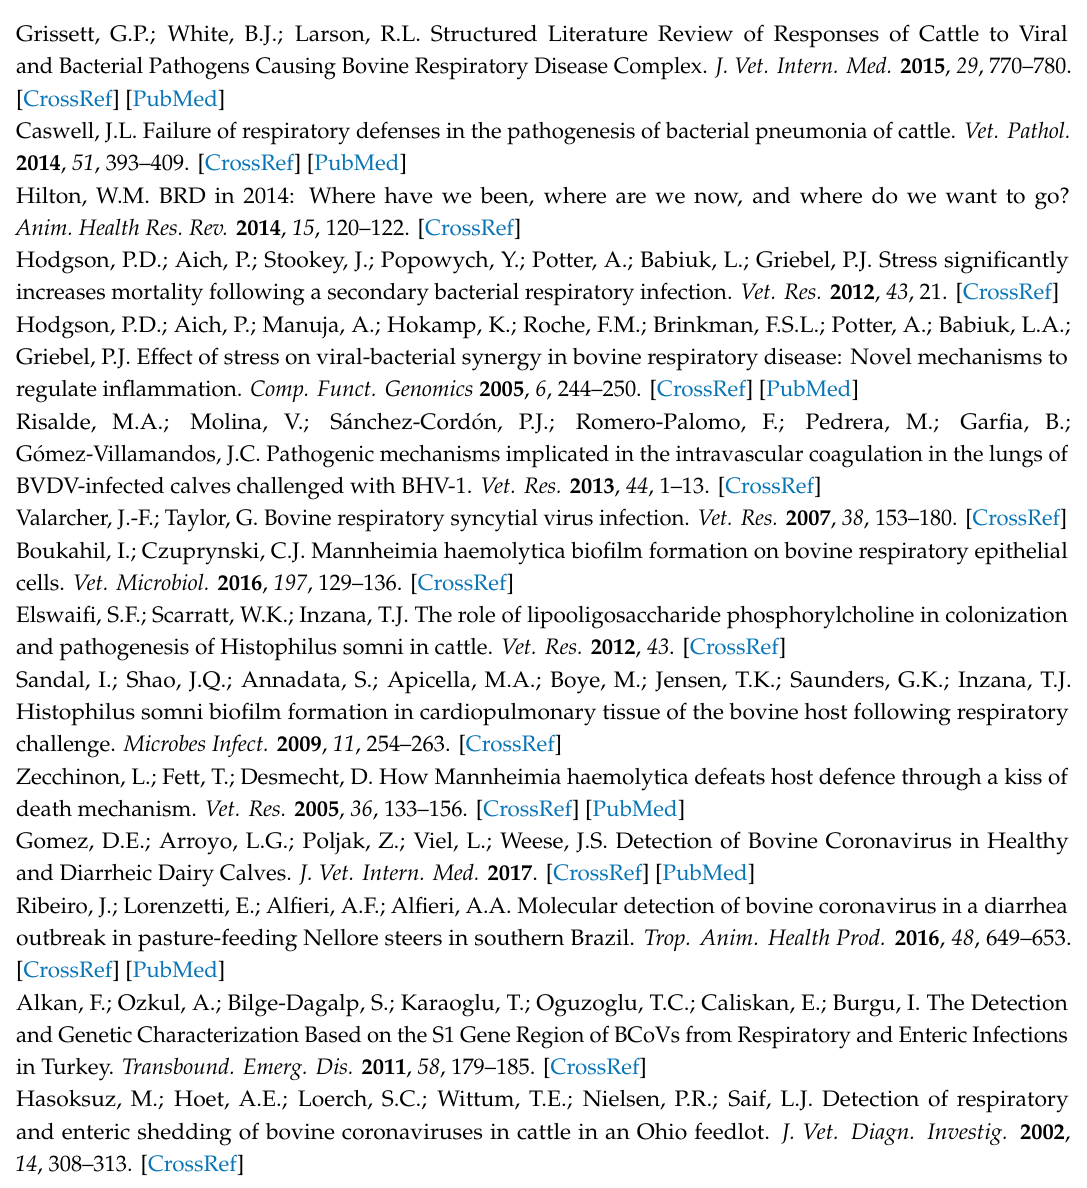
Table S1: Details of the strains used for S gene sequences analyses, Table S2: Details of the strains used for N gene sequences